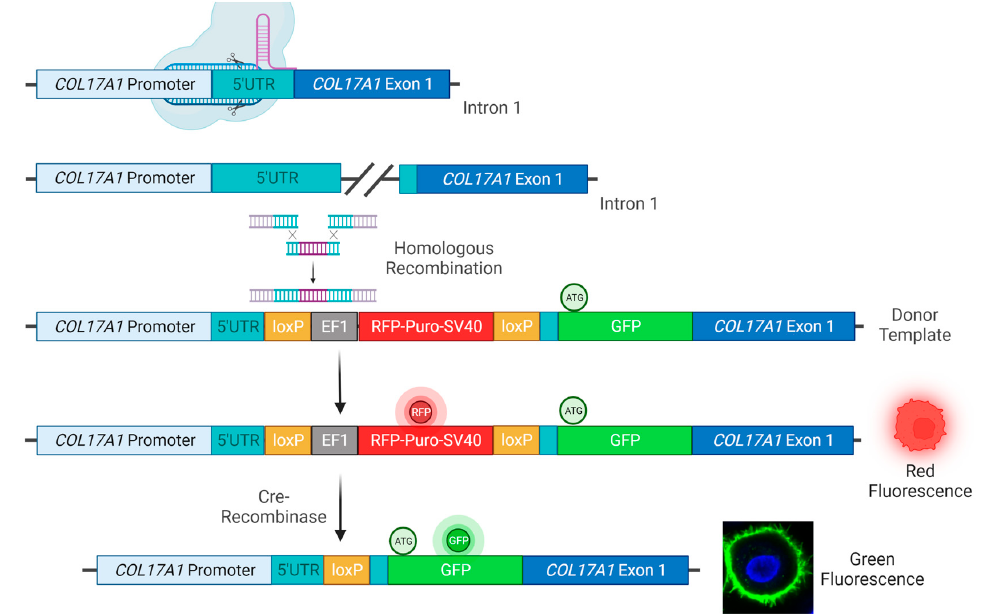
Figure 1. CRISPR/Cas9-mediated integration of GFP at the COL17A1 locus. Upon delivery of a Cas9/sgRNA-expressing plasmid and an HR template, comprising an RFP-puromycin selection cassette and GFP flanked by a 5 ′ and 3 ′ HA for homologous recombination, into human WT and JEB keratinocytes the Cas9 nuclease/nickase performs a double/single-strand DNA break within the 5 ′ UTR of COL17A1. This DNA damage induces HDR at the COL17A1 locus leading to the integration of the selection cassette and GFP at the target site. The RFP-puromycin selection cassette, initially required for the isolation of cell clones in which the HR template sequence is integrated, was then removed via Cre-recombinase-treatment leaving one loxP site as a DNA footprint within the UTR. The GFP reporter molecule was then fused in frame to the COL17A1 gene via a short Gly- Ser-linker sequence leading to the expression of a GFP-C17 fusion protein in the cell under expression control of the endogenous promoter. A pure GFP pos /RFP neg cell population was then obtained via FACS. Created with BioRender.com. Flow cytometric analysis was performed after each treatment step to monitor the success of the cell line generation. Upon co-transfection with the Cas9/sgRNA-expressing plasmid and the HR template plasmid, both WT and JEB keratinocytes expressed RFP- Puro and GFP from the HR template and the Cas9/sgRNA-expressing plasmid, respectively (Figure 2). Keratinocytes with successfully integrated HR templates were then selected via puromycin treatment. A subsequent Cre-recombinase-mediated deletion of the selection cassette brought the GFP-C17 expression under the control of the endogenous COL17A1 promoter. This resulted in a cell population exclusively emitting green fluorescence (~38% of WT Kc and ~1.7% of JEB Kc). To further purify the GFP-C17- expressing cell population, a GFP pos /RFP neg sort was implemented, resulting in ~97% of treated WT Kc and ~72% of treated JEB Kc displaying a green signal detectable by flow cytometric analysis (Figure 2). Notably, the median fluorescence intensities (MFI) of GFP varied between both keratinocyte populations. As expected, the GFP signal is higher in GFP-sorted WT keratinocytes (MFI: 5255) due to normal expression of GFP-C17 in the cells. In comparison, in GFP-sorted JEB keratinocytes, in which C17 expression is disrupted, the intensity of the GFP signal is lower (MFI: 2681). In this case, sorting for GFP-positive cells enriched for those cells with residual levels of truncated GFP-C17 mut proteins, as the homozygous frameshift mutation in exon 52 results in a premature termination codon.